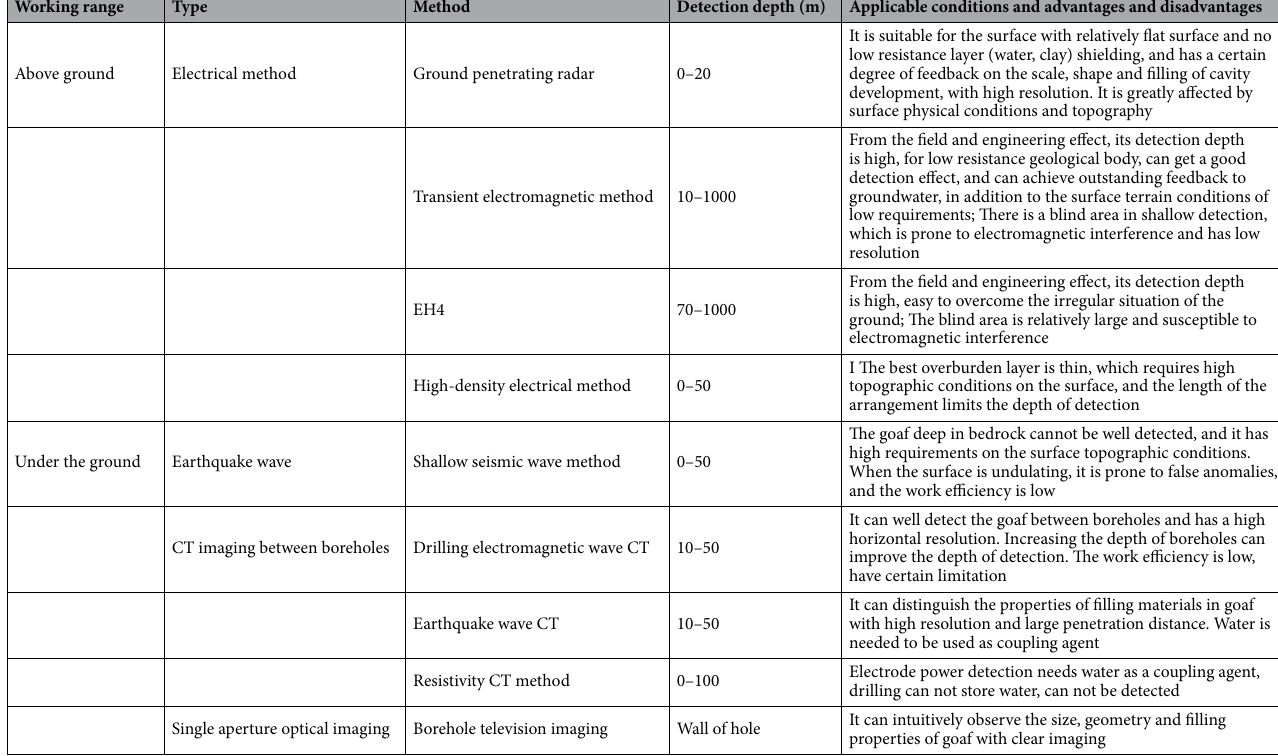
Table 1. Several common goaf detection methods divided according to working range, type, method, detection depth and their characteristics. a joint detection method suitable for complex goaf is selected, that is, Transient electro-magnetic method, Ground penetrat-ing radar and High-density elec-trical